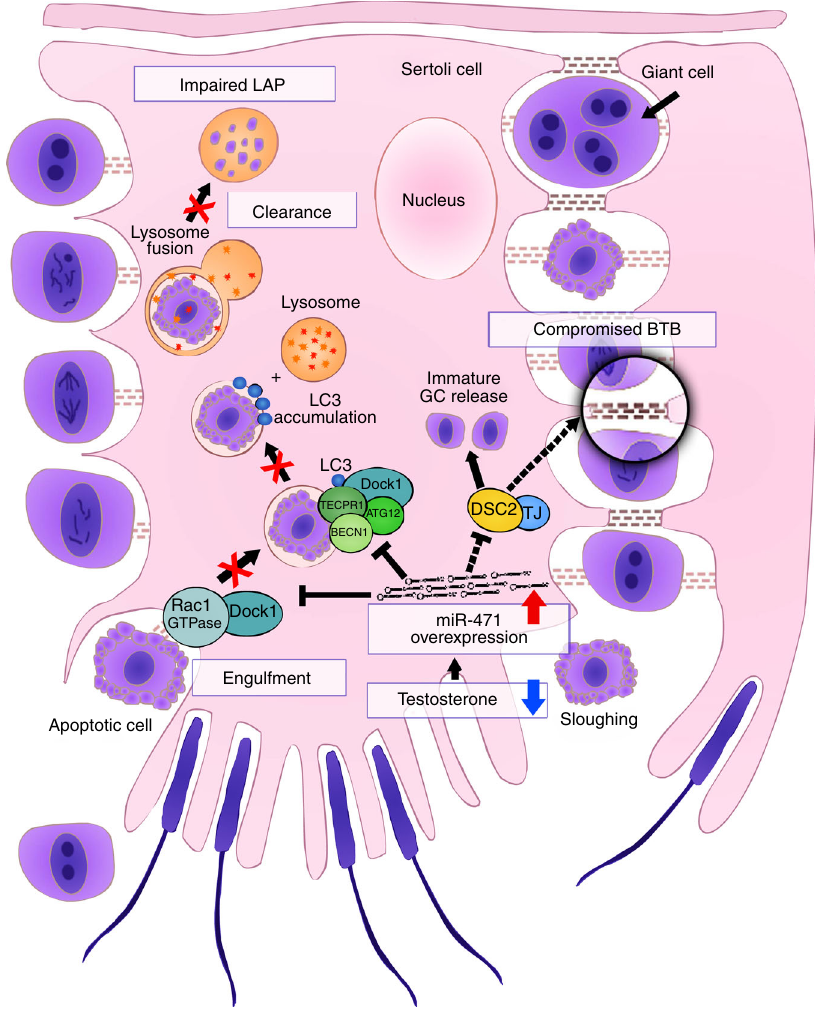
Fig. 7 Role of androgen-responsive miR-471-5p in Sertoli cell. Model showing miR-471-5p regulation of Sertoli cell functions. We posit that lower than normal levels of androgen will increase miR-471-5p expression in Sertoli cells, leading to inhibition of target genes including Dock1 (Dock180) , Atg12 , Tecpr1 , and Becn1 . The decreased levels of Dock180 and other autophagy-associated genes in turn impairs LAP by inhibiting engulfment and/or phagolysosome maturation and consequently clearance of apoptotic germ cells by the Sertoli cells. In addition to LAP-associated proteins, miR-471-5p also regulates expression of BTB associated proteins, including Dsc2. Since Dsc2 is an integral component of desmosome junction, which is the primary attachment site for developing germ cell, it is possible that miR-471-5p promotes immature release of germ cells and consequently their apoptosis via Dsc2. Taken together, our results suggest that maintaining an optimal level of key genes, which are important for engulfment and clearance of apoptotic germ cells as well as BTB integrity in Sertoli cells, is critical for proper germ development and differentiation and male fertility. GC- Germ